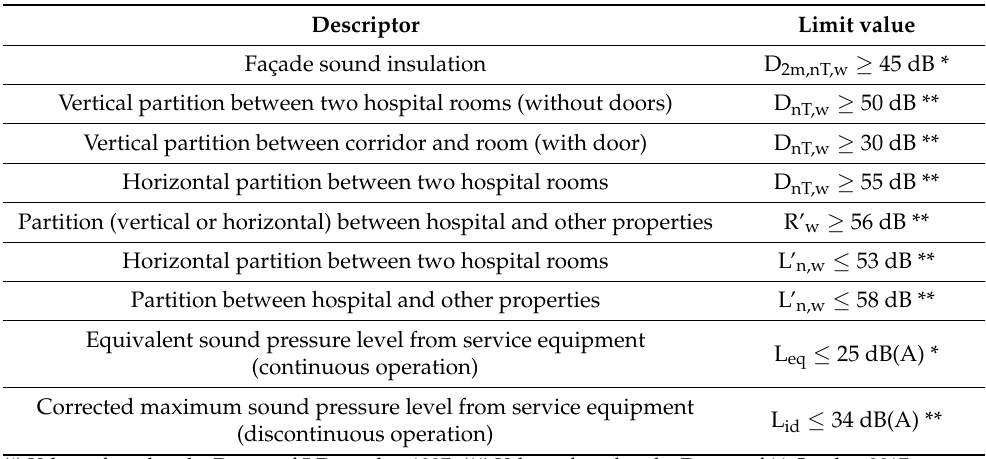
Table 1. Limit values of airborne sound insulation, impact noise, and service equipment noise for public hospitals in